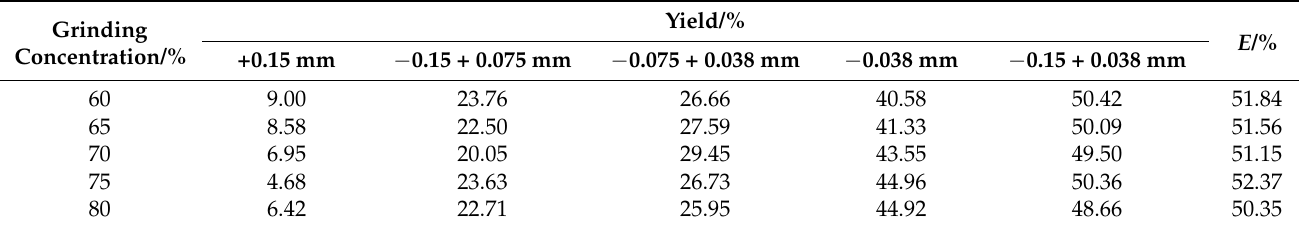
Table 9. Particle size composition of grinding product at different grinding concentrations.